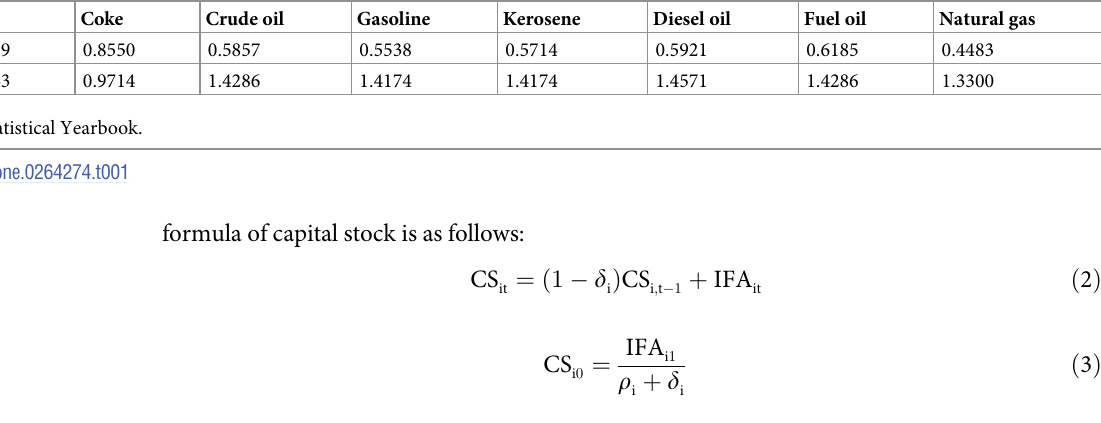
Where CS and CS respectively represent the capital stock in t and t − 1 periods, and CS it i,t − 1 indicates the initial capital stock. IFA denotes the total investment in fixed assets after adjust- it ment in period t . δ and ρ respectively represent the asset depreciation rate and the average i i annual investment growth rate under a fixed price, in which the value of δ 9.6%.